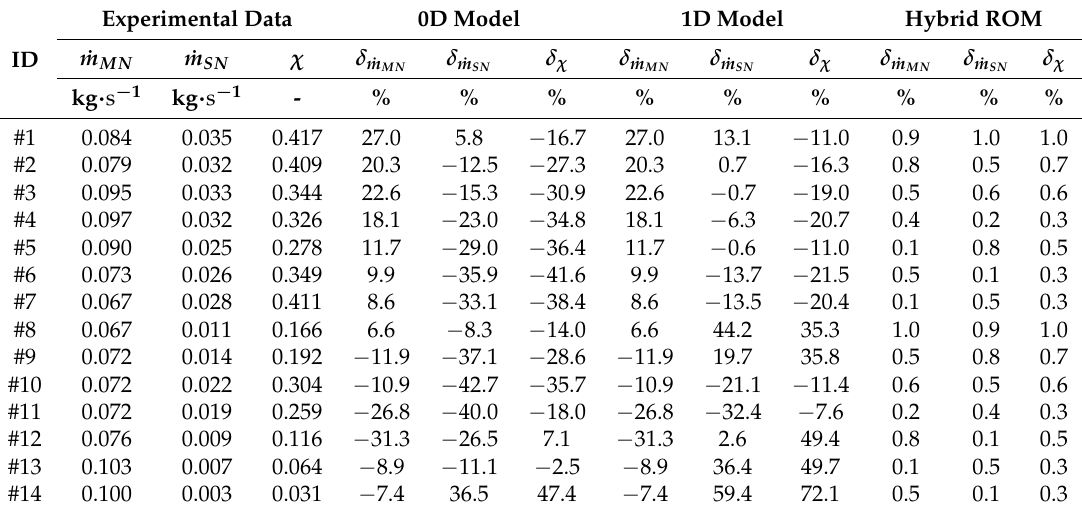
Table 3. The results given by each mathematical